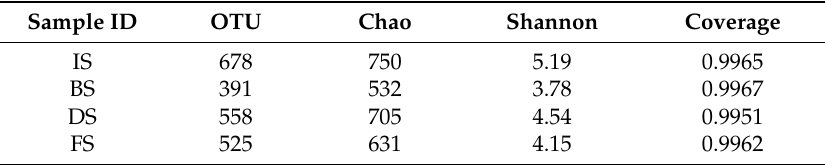
Table 4. Species diversity and richness estimators for the four